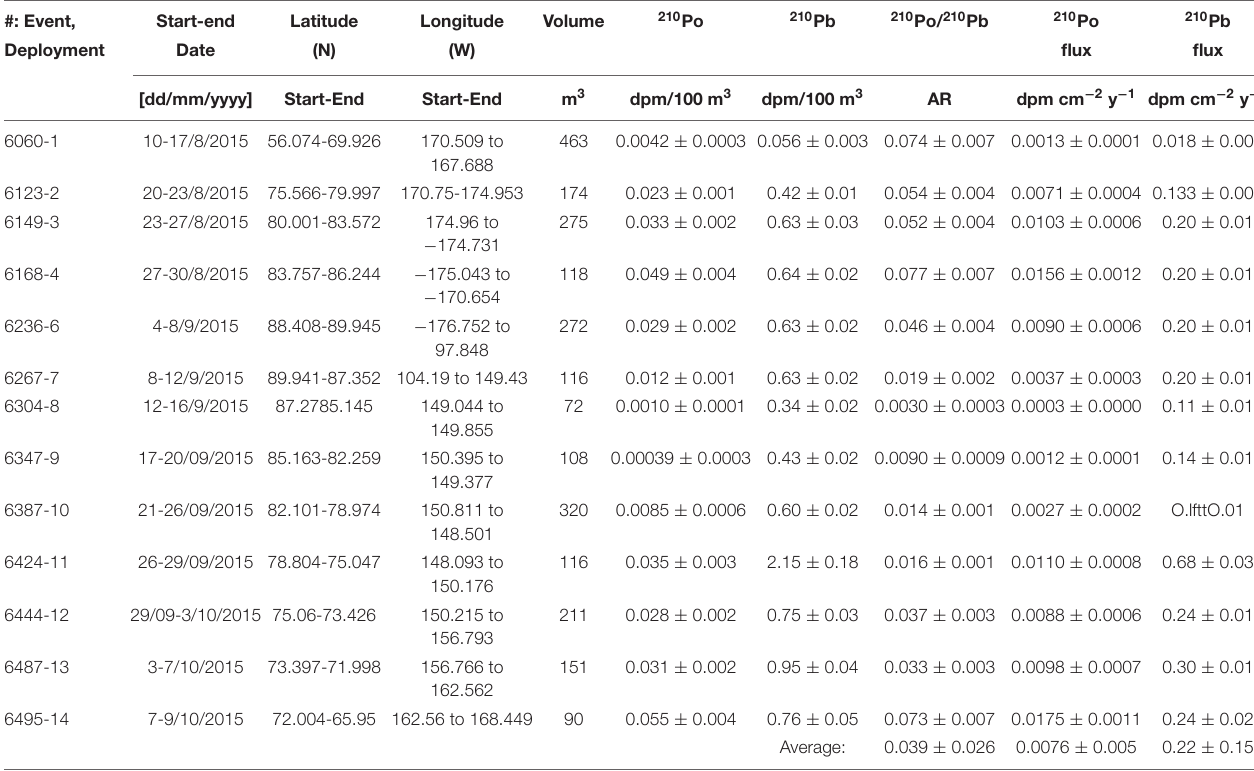
TABLE 1 | Aerosol collection time, location, volume, activities and depositional fluxes of 210 Po and 210 Pb and 210 Po/ 210 Pb AR. #: